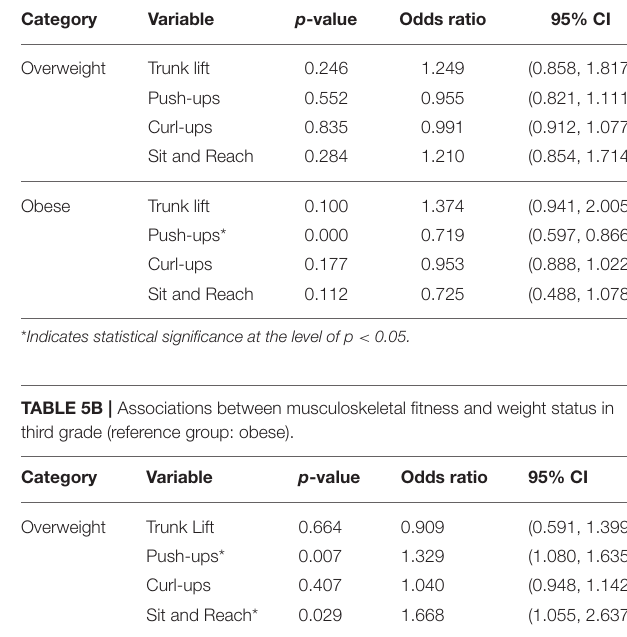
TABLE 5A | Associations between musculoskeletal fitness and weight status in third grade (reference group: healthy weight). Category Overweight